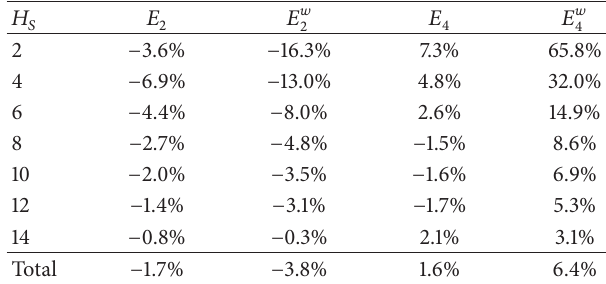
Table 1: Deviations on accumulated tension force